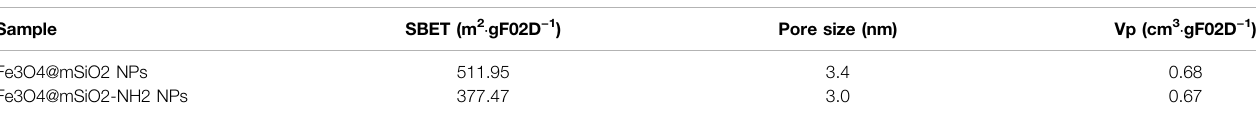
TABLE 1 | Texture properties of Fe3O4@mSiO2 NPs and Fe3O4@mSiO2-NH2 NPs.